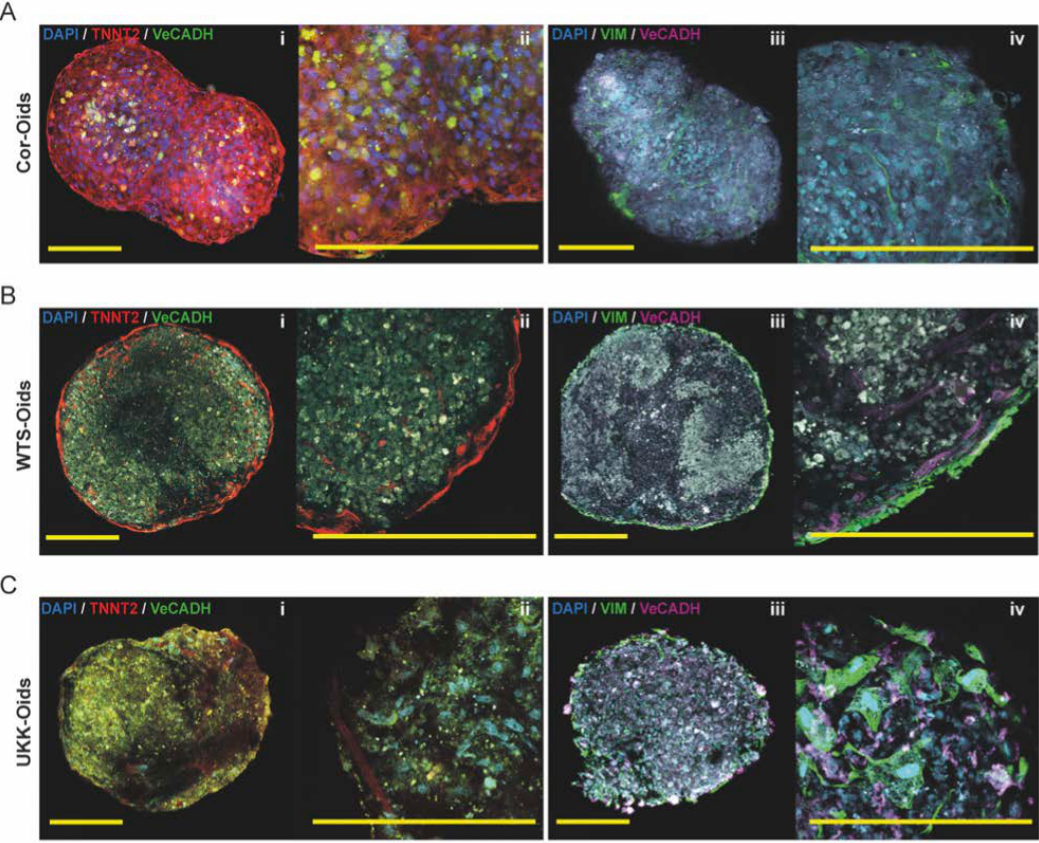
Figure 4. Determining the structural development of cardiac organoids. ( A – C ) Immunofluorescence images of Cor-Oids, WTS-Oids and UKK-Oids after 21 days of culture, labelled with cardiac-specific troponin (TNNT2), vascular cadherin (VeCADH) and vimentin (VIM). We identified similar structural patterns ( A – C , iii–iv) in all organoid types, in terms of HCMEC (magenta) and HCF (green) distribution. Di ff erent structural development patterns were observed regarding the migration of hiPSC-CMs and the formation of cardiac filament-like structures (red), which were well-defined in Cor-Oids ( A , i–ii), mostly perimetric in WTS-Oids ( B , i–ii), and still in formation in UKK-Oids ( C, i–ii). Scale bars = 200 µ